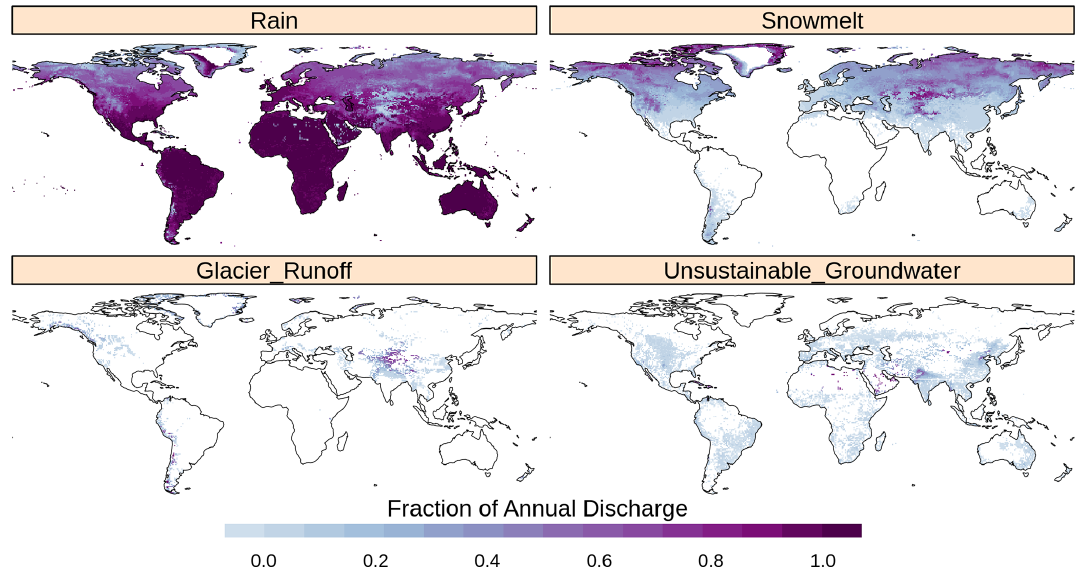
Figure 7. The fraction of average annual discharge composed of the four different primary source water components used in the primary source tracking method.